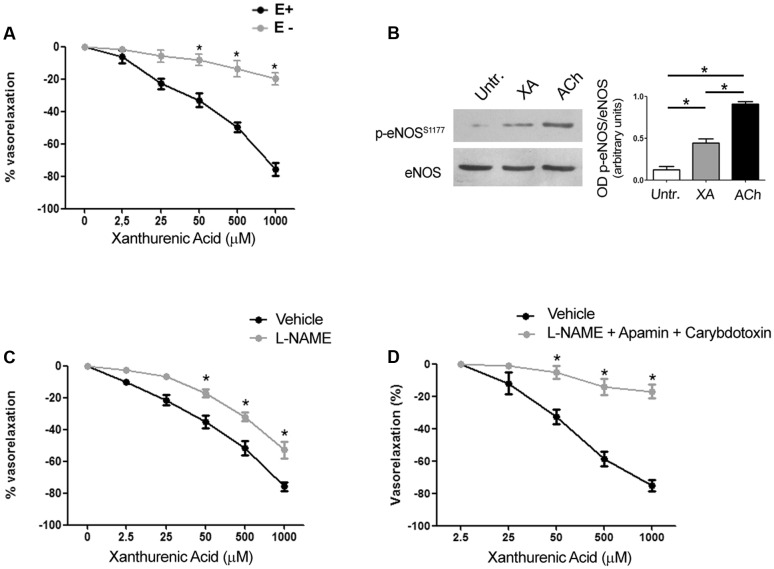
Arterial relaxation induced by xanthurenic acid (XA) is mediated by nitric oxide and EDHF. (A) Vascular response of phenylephrine-precontracted mouse mesenteric arteries to increasing concentrations of XA (0–1000 μM) in the presence (E+) or absence of endothelium (E–). Values are means ± S.E.M. of five determinations. ∗p < 0.05; (Two-way ANOVA + Bonferroni post-test) vs. E+. (B) Representative cropped immunoblot of mouse mesenteric arteries treated with 500 μM XA or 1 μM acetylcholine (ACh) used as positive control. Densitometric values are means ± S.E.M. of four determinations. ∗p < 0.05 (One-way ANOVA + Kruskal-Wallis test). (C) Vascular response of phenylephrine-precontracted mouse mesenteric arteries to increasing concentrations of XA (0–1000 μM) in the absence or presence of (300 μM) L-NAME. Values are means ± S.E.M. of six determinations. ∗p < 0.05: (Two-way ANOVA + Bonferroni post-test). (D) Vascular response of phenylephrine-precontracted mouse mesenteric arteries to increasing concentrations of XA (0–1000 μM) in presence of (300 μM) L-NAME plus a cocktail of EDHF inhibitors (50 nM apamin and 50 nM charybdotoxin). Values are means ± S.E.M. of six determinations. ∗p < 0.05 (Two-way ANOVA + Bonferroni post-test).